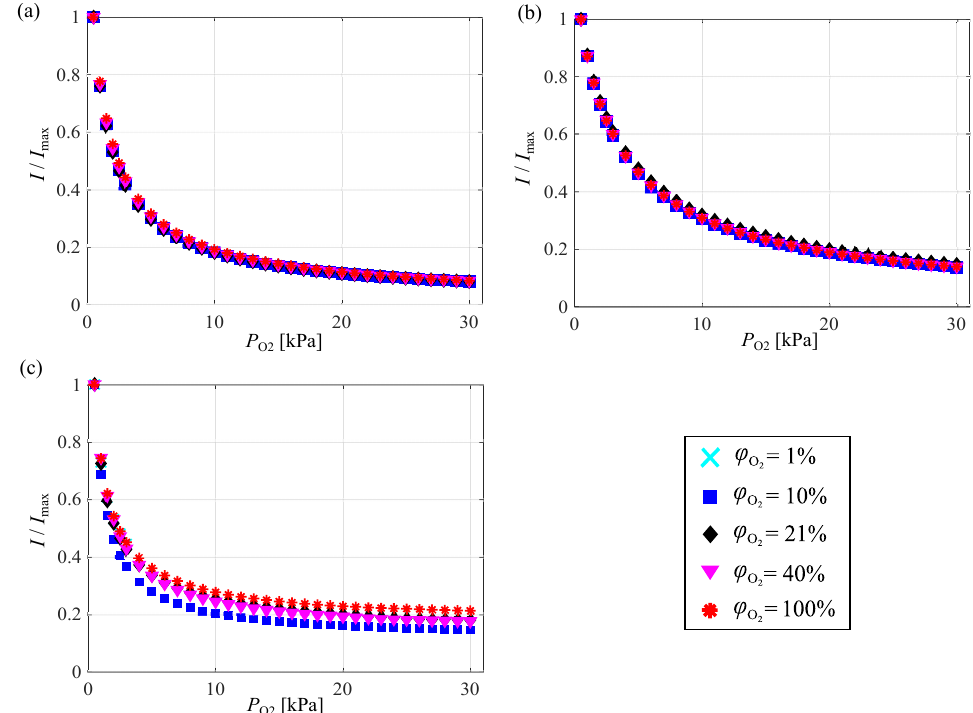
Figure 6. Normalized intensity of PSP emission versus partial pressure of oxygen at various oxygen mole fractions for ( a ) PHFIPM-PSP, ( b ) PC-PSP, and ( c )